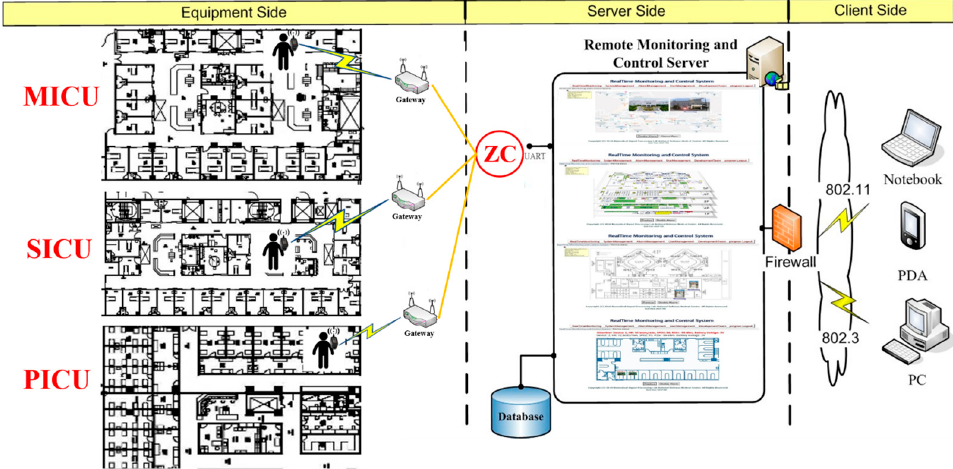
Figure 9. Architecture diagram of wireless monitoring system in the intensive care unit.